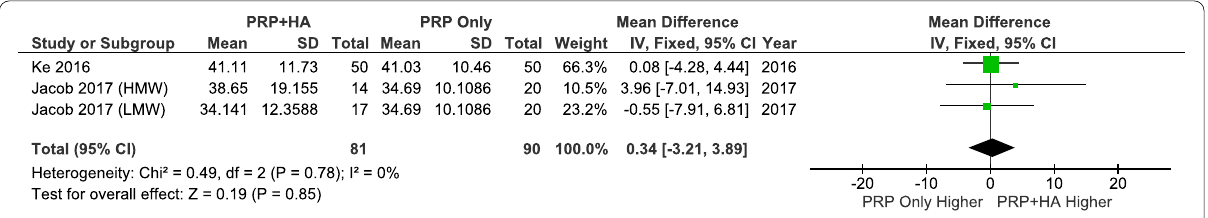
Fig. 15 Showing the Forest plot comparing the IKDC scores between PRP